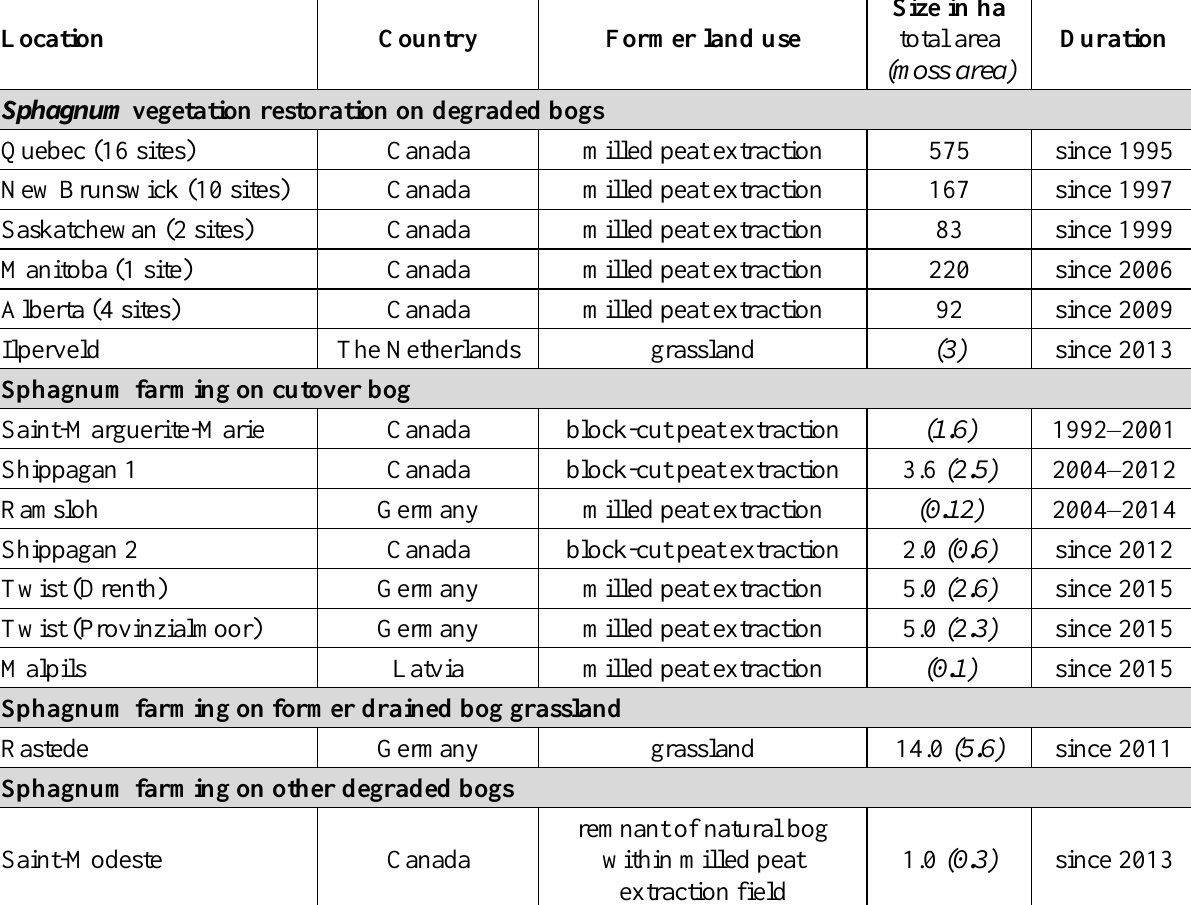
Table 1. Overview of selected Sphagnum vegetation restoration projects ≥ 3 ha and Sphagnum farming trials. Smaller Sphagnum vegetation restoration projects have been implemented, e.g . in Estonia (near Tässi), Germany (peatland Dalumer Moor), Lithuania (Aukštumala peatland) and the United Kingdom (Wales). Further information at